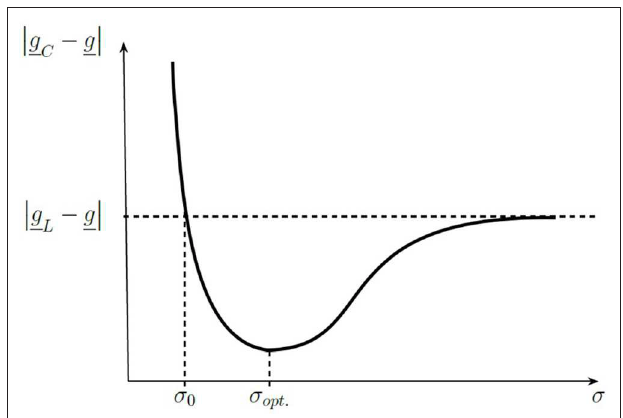
− g g between Capon’s estimator g (cid:12) (cid:12) C C (cid:12) (cid:12) and the L − g − g ≤ g g , (cid:12) (cid:12) (cid:12) (cid:12) C L (cid:12) (cid:12) (cid:12) (cid:12)